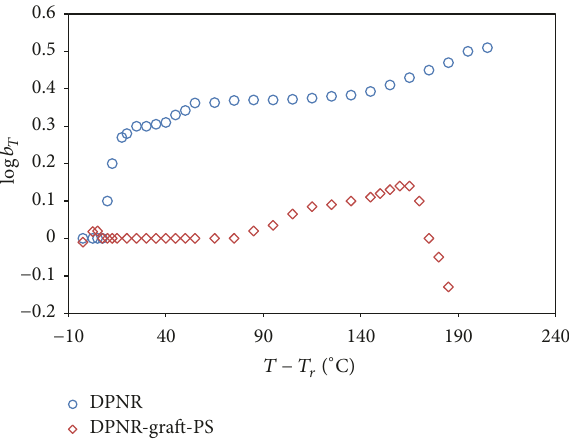
Figure 10: Temperature dependence of 𝑏 𝑇 of DPNR and DPNR- graft